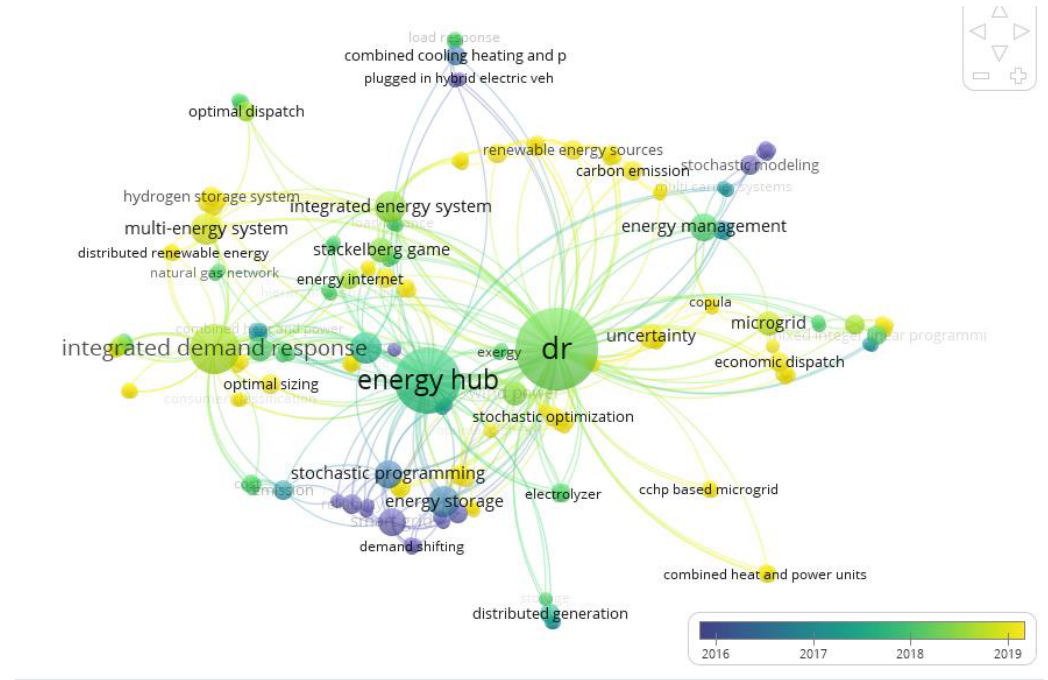
Figure 8. Main keywords and the temporal relationship between them.